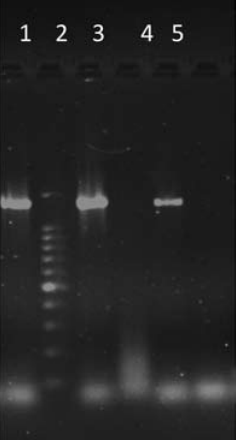
Fig. 1. Agarose gel electrophoresis of 16S rRNA specific PCR of Staphylococci spp. Lane 1 – Ladder Lane 7 – Positive control Lane 8 – Negative control Lane 2,3,4,5,6,7 – Positive samples (756 bp)